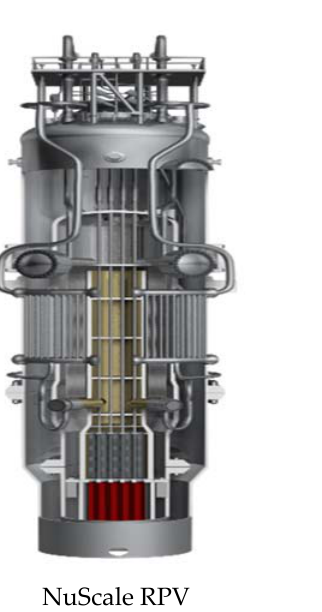
Figure 5. Layout of the reactor pressure vessels of two SMR designs [31,32].